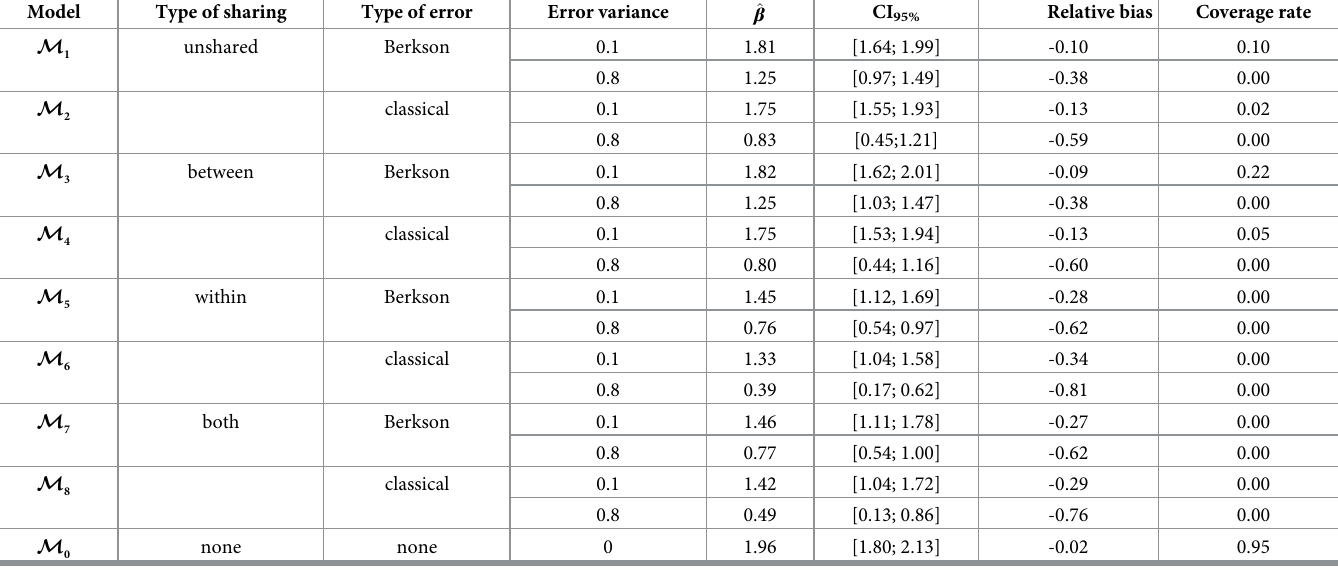
Table 1. Average posterior median ( ^ β ), overall 95% credible intervals (CI 95% ), relative bias and coverage rate for 100 data sets generated according to the Cox model , a measurement model among M D 2